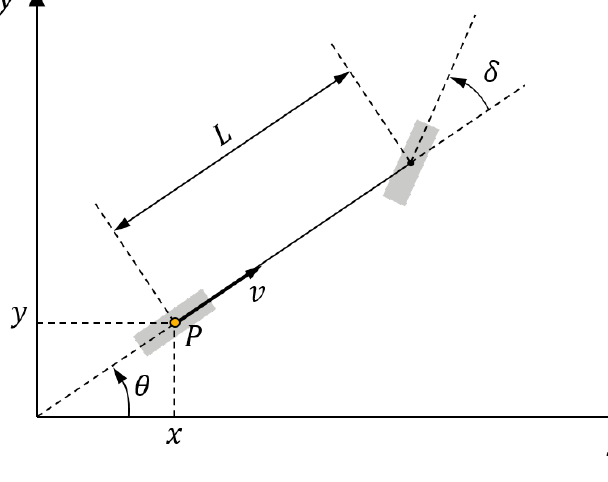
Figure 6. Vehicle kinematic